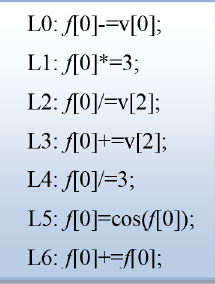
Fig. 3. An excerpt of a linear genetic